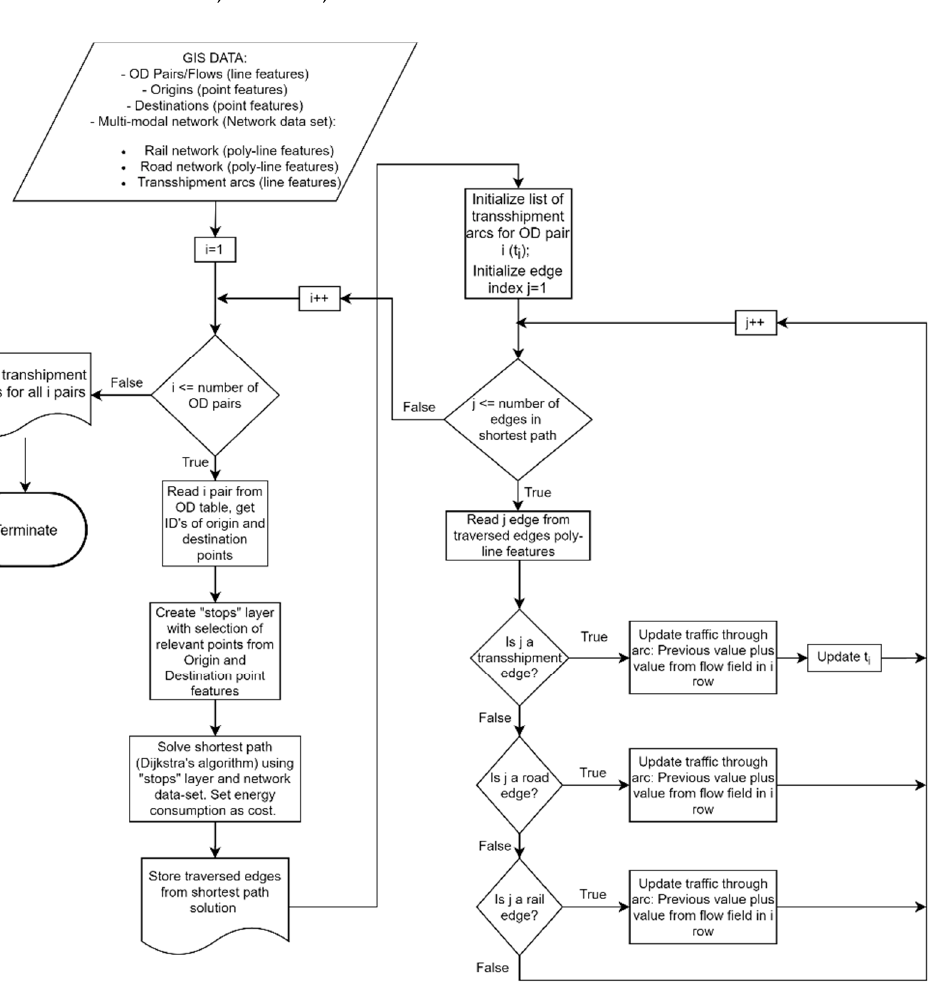
Figure 2. GIS-based network model algorithm.